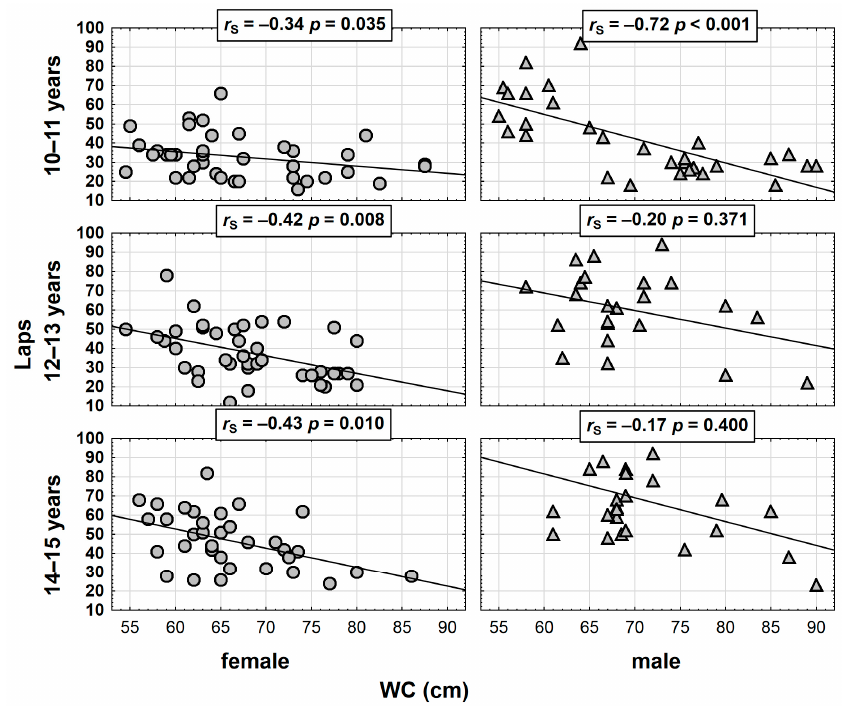
Figure 1. Distribution of CRF test results (number of laps) with reference to the WC for particular age groups among the girls and the boys.